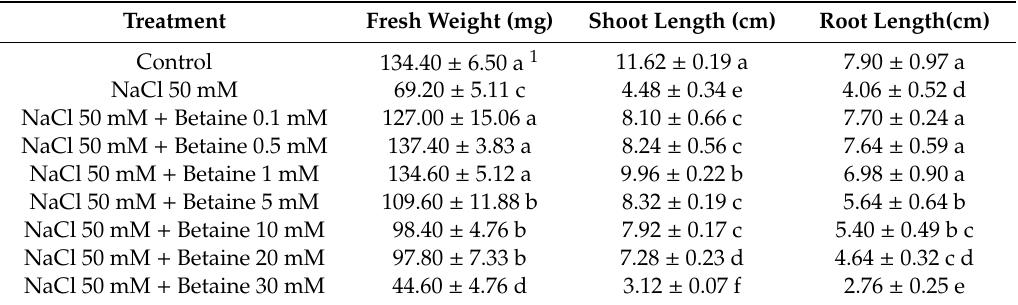
Table 3. E ff ect of NaCl 50 mM with di ff erent concentrations of betaine hydrochloride treatment on the growth of Tartary buckwheat